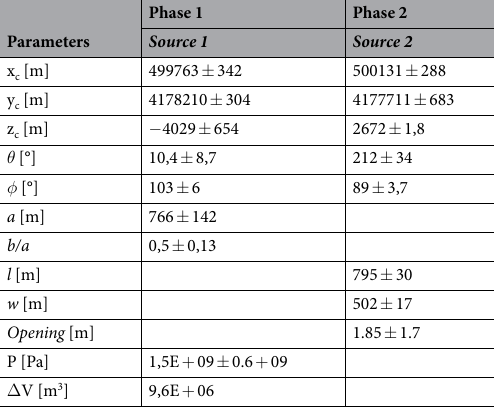
Table 1. Model parameters and related uncertainties: x c , y c and z c are the coordinates of the sources, θ is the azimuth measured counterclockwise from the positive y direction around the z axis, φ is the dipping angle measured clockwise from the positive y direction around the x axis, a is the major semiaxis, b/a is the ratio between the minor and major axes, P is the intensity of the pressure on the surface of the spheroid, ∆ V is the changing volume calculated according to Tiampo et al . 62 using a value of the effective shear modulus µ equal to 5